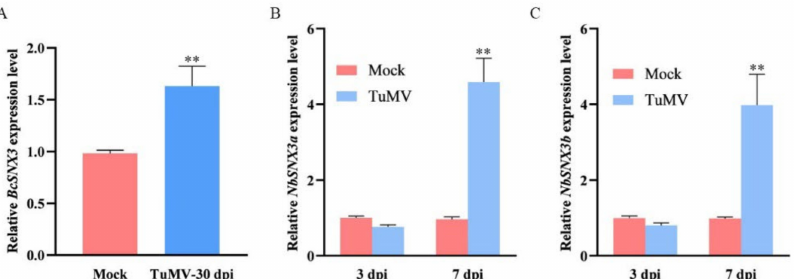
Figure 1. TuMV infection facilitated the expression level of SNX3 . ( A ) RT-qPCR analysis of SNX3 mRNA level in mock (infiltrated with buffer) and TuMV-infected pak-choi. ( B , C ) RT-qPCR analysis of SNX3a ( B ) and SNX3b ( C ) mRNA level in mock (infiltrated with buffer) and TuMV-infected N. benthamiana plants at 3 days post-infiltration (dpi) and 7 dpi. Statistical significance (**, p < 0.05)